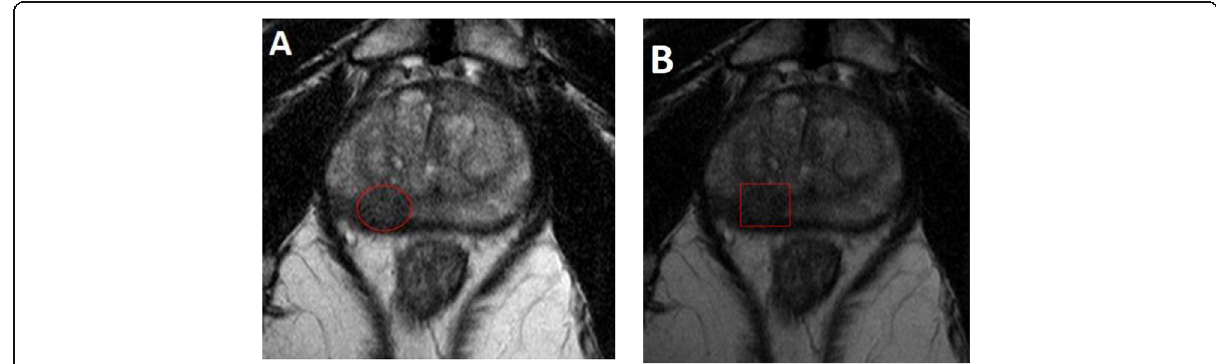
Fig. 2 The true prediction from 100-tag iteration: a radiologist identified 1 lesion (red circle) in a testing image. b AI predicted 1 lesion (red rectangle) at the true position